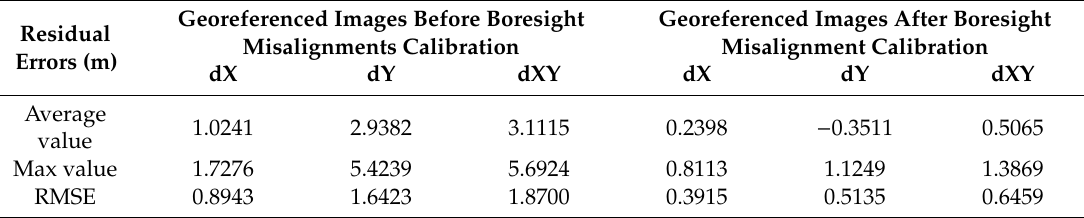
Table 6. Comparison of the performance of our method and six others by RMSE along x and y axes, which are denoted RMSEx and RMSEy, respectively. RMSExy =